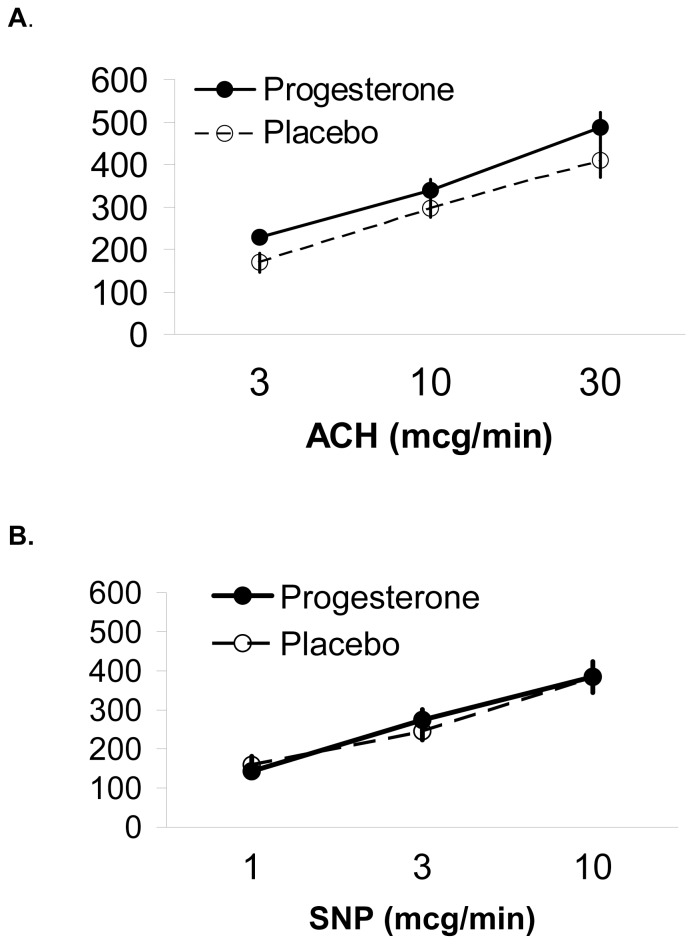
Endothelial Function on Progesterone or Placebo.Forearm venous occlusion plethysmography was performed in 34 healthy early postmenopausal women in a randomized, placebo-controlled trial of oral micronized progesterone (300 mg, Progesterone) for hot flushes. This plot shows dose responses in forearm blood flow (FBF) to intra-brachial artery infusions of vasodilators: A. nitric oxide-releasing, endothelium-dependent (acetylcholine - ACh); B. endothelium-independent (sodium nitroprusside - SNP). Data are mean ± SE of percentage (%) increase in FBF above saline baseline for those randomized to Progesterone (n = 18) and Placebo (n = 16). The 15% increase in FBF at each dose of ACh during Progesterone therapy was not statistically significant.